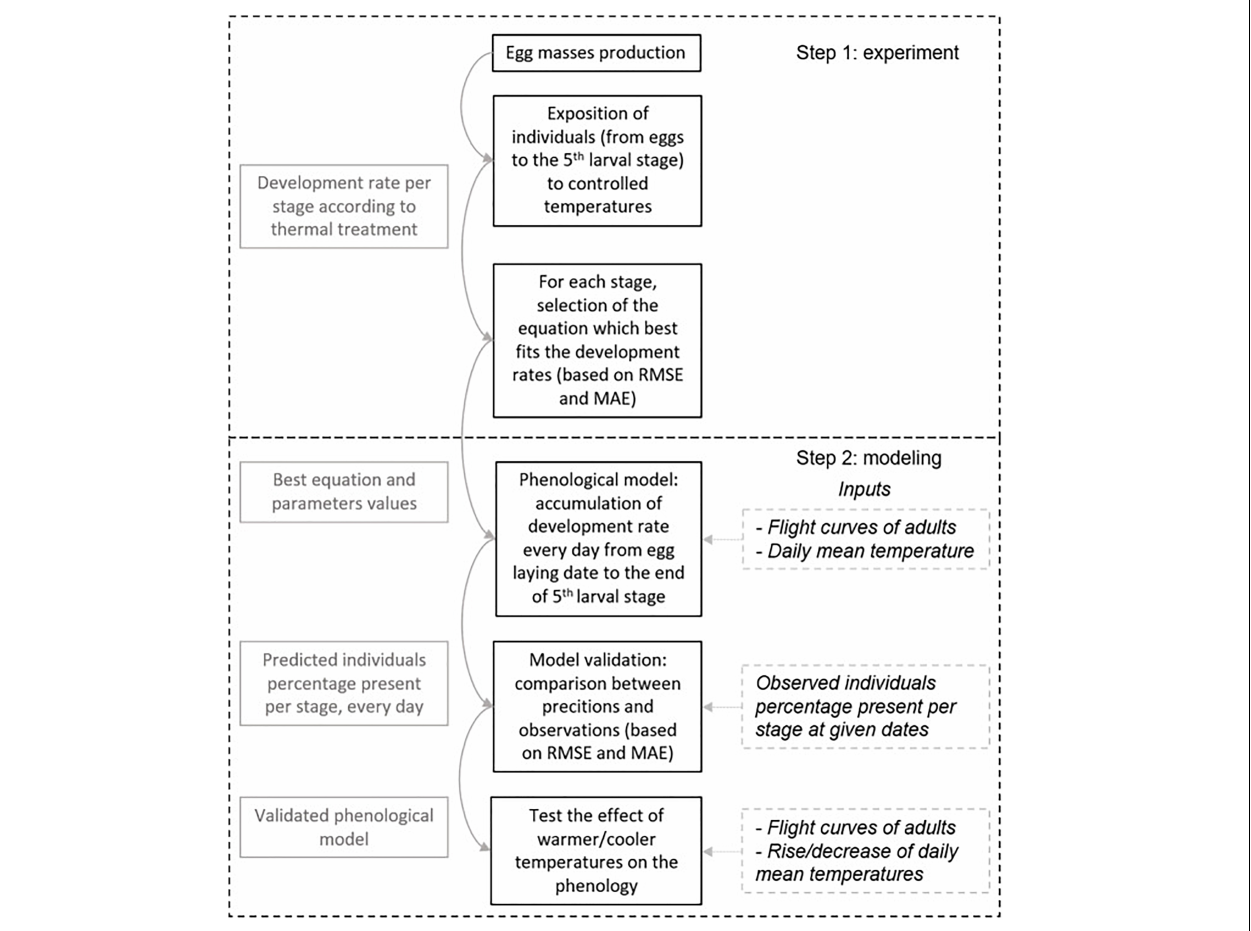
FIGURE 1 | Approach description. Solid black boxes represent the main steps of the approach. Solid gray boxes indicate that the results of one step are used in the following. Dashed gray boxes are model